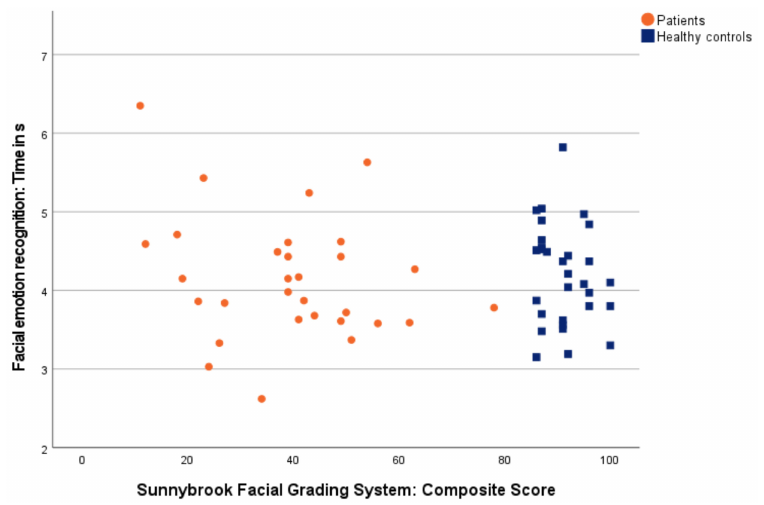
Figure 6. Correlation between time of facial emotion recognition and grading of facial palsy. Patients are shown as orange dots, and healthy controls as blue